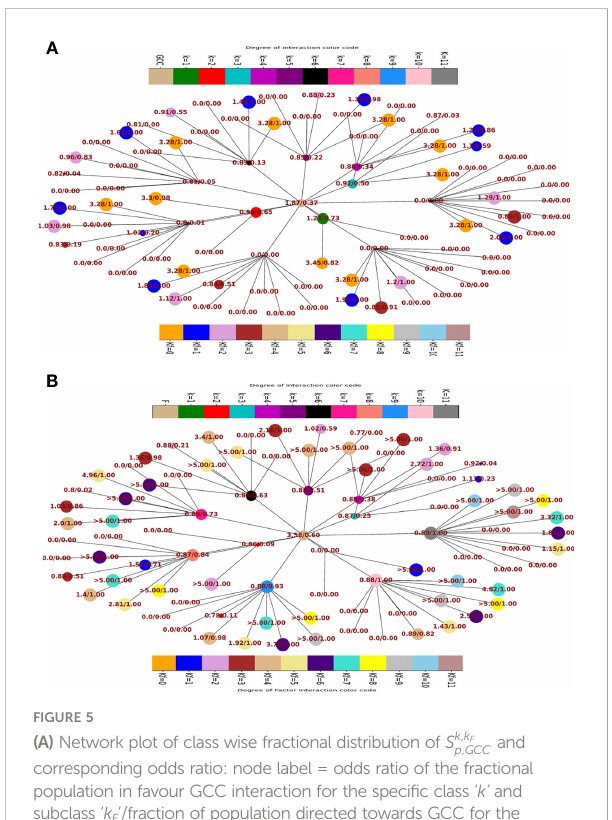
(A) Network plot of class wise fractional distribution of S k , k F p , GCC and corresponding odds ratio: node label = odds ratio of the fractional population in favour GCC interaction for the speci fi c class ‘ k ’ and subclass ‘ k F ’ /fraction of population directed towards GCC for the speci fi c class ‘ k ’ and subclass ‘ k F ’ . (B) Network plot of class wise fractional distribution of S k , k F p , GCC and corresponding odds ratio: node label = odds ratio of the fractional population in favour of F interaction for the speci fi c class ‘ k ’ and subclass ‘ k F ’ /fraction of population directed towards F for the speci fi c class ‘ k ’ and subclass ‘ k F ’